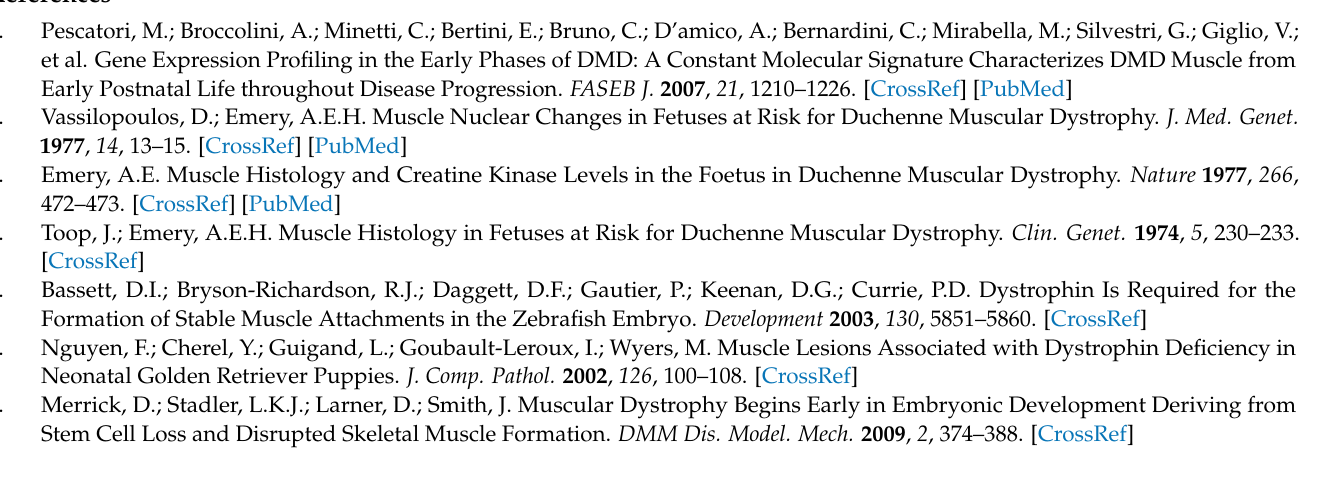
displayed. Table S4. DMD gene expression in 13 TCGA primary tumors compared to NATs from the TCGA and healthy GTEx tissues. p -Values were calculated using the UCSC Xena Browser and